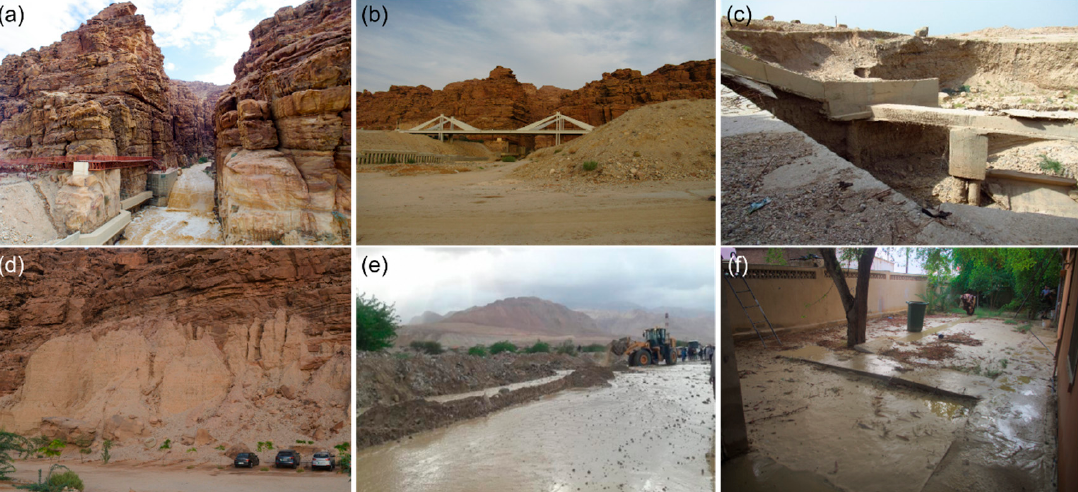
Figure 6. Erosion and floods after storms and flash floods near the Dead Sea Highway in 2018 ( a ) Wadi Mujib during a flash flood, ( b ) its new bridge, ( c ) destroyed old constructions and ( d ) rockfalls at the parking area. ( e ) shows flooding near the road between Ghor Al ‐ Safi and Ghor Al ‐ Mazra’a in 2020 [60] and ( f ) shows housing at Ghor Al ‐ Haditha after a heavy rain and flood event in the town. Photo ( d ) was taken by Robert Alban Watson, photos ( a – c , f ) were taken by Djamil Al ‐ Halbouni.